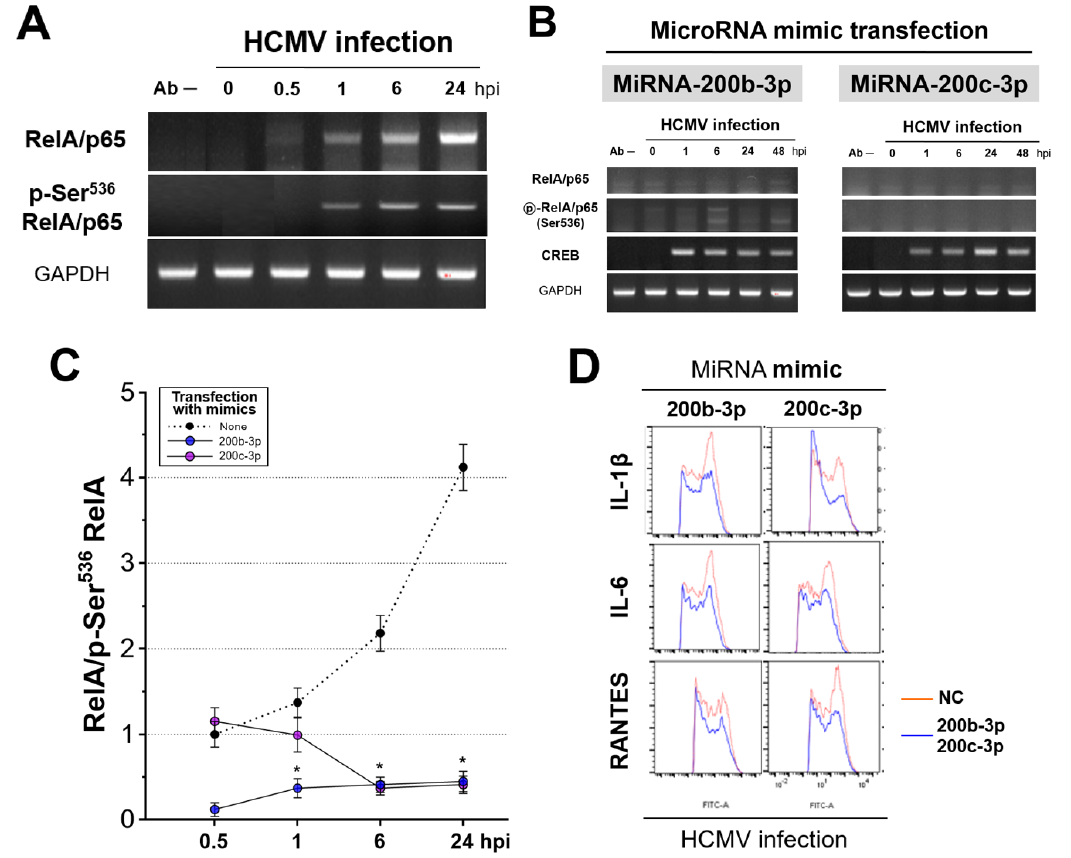
Figure 7. Nuclear factor − kappa B RelA/p65 phosphorylated at Ser 536 bound to MIEP enhancer region and upregulated miR ‐ 200b ‐ 3p and miR ‐ 200c ‐ 3p led to increased p ‐ Ser 536 RelA/p65 binding to MIEP and decreased pro ‐ inflammatory cytokine expression. We amplified the MIEP enhancer region by PCR in two cell groups after ChIP with RelA/p65 and p ‐ Ser 536 RelA/p65 mAbs. HFF ‐ 1 cells infected with HCMV Towne strain (MOI of 0.1) without ( A ) and with ( B ) miR ‐ 200b ‐ 3p or miR ‐ 200c ‐ 3p mimic transfection at indicated time points. ( C ) Band intensity of NF ‐κ B RelA/p65 and p ‐ Ser 536 RelA/p65 is expressed as the ratio of amplified DNAs. ( D ) The expression of IL ‐ 1 β , IL ‐ 6, and RANTES (CCL5) at 2 dpi in HFF ‐ 1 cells infected with the HCMV Towne strain and in those transfected with miR ‐ 200b ‐ 3p, miR ‐ 200c ‐ 3p, and NC mimic measured by flow cytometry. Dots and error bars indicate means and SEM, respectively. * p < 0.001 vs. cells without transfected microRNA mimic. In contrast to natural acute HCMV infection, transfection with miR ‐ 200b ‐ 3p and miR ‐ 200c ‐ 3p mimics induced the binding of p ‐ Ser 536 RelA/p65 to MIEP to a greater extent than that observed with RelA/p65 (Figure 7B). The ratio of RelA/p65 to p ‐ Ser 536 RelA/p65 at MIEP decreased over time in HFF ‐ 1 cells transfected with miR ‐ 200b ‐ 3p/200c ‐ 3p mimics with significant changes at 6 and 24 hpi for both miR ‐ 200b ‐ 3p and miR ‐ 200c ‐ 3p. Opposite results were observed in cells without mimic transfection (Figure 7C). We also found that the upregulation of miR ‐ 200b ‐ 3p and miR ‐ 200c ‐ 3p results in decreased levels of pro ‐ in ‐ flammatory interleukin (IL) ‐ 1 β , IL ‐ 6, and RANTES (CCL5), all of which are induced in response to NF ‐κ B activation (Figure 7D). These data suggested that downregulating the expression of IE proteins by upregulating the levels of miR ‐ 200b ‐ 3p and miR ‐ 200c ‐ 3p can